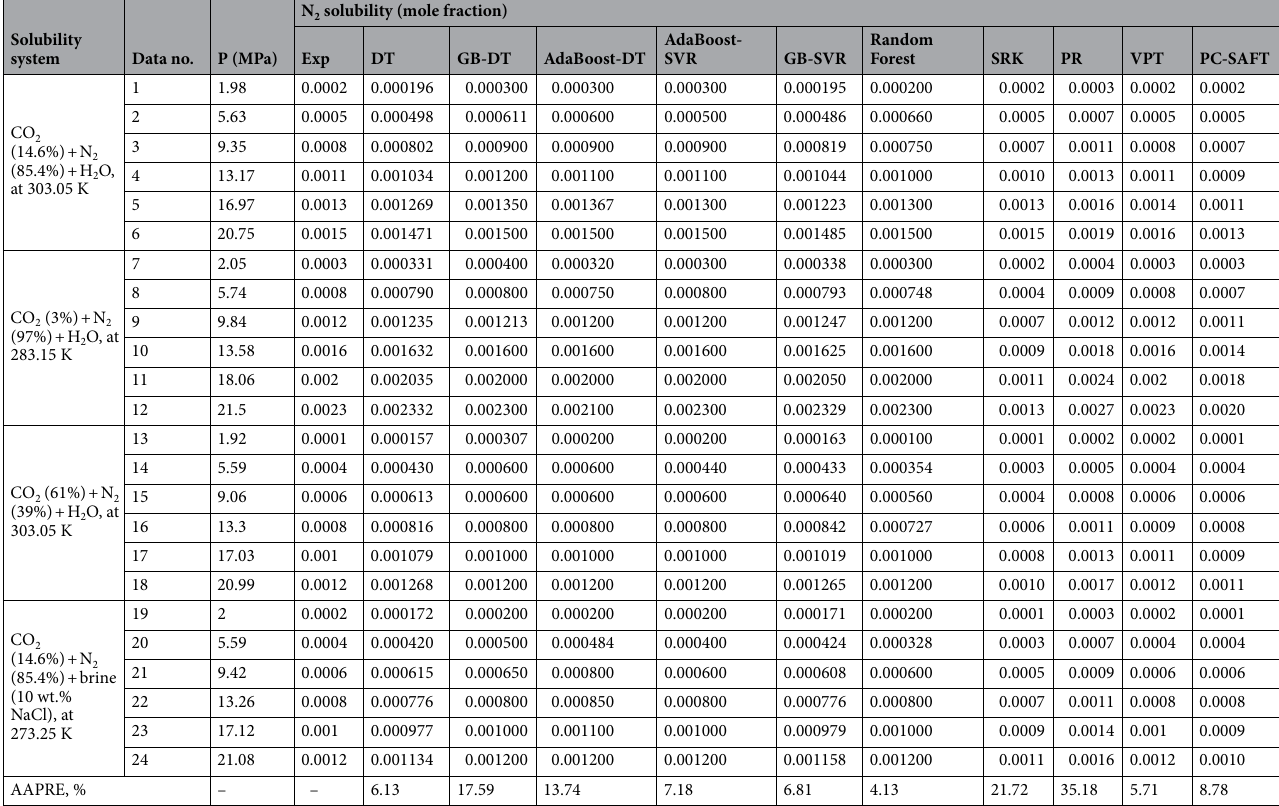
Table 7. Predictions of EOSs and smart models for N 2 solubility in different CO 2 + N 2 + H 2 O (brine)